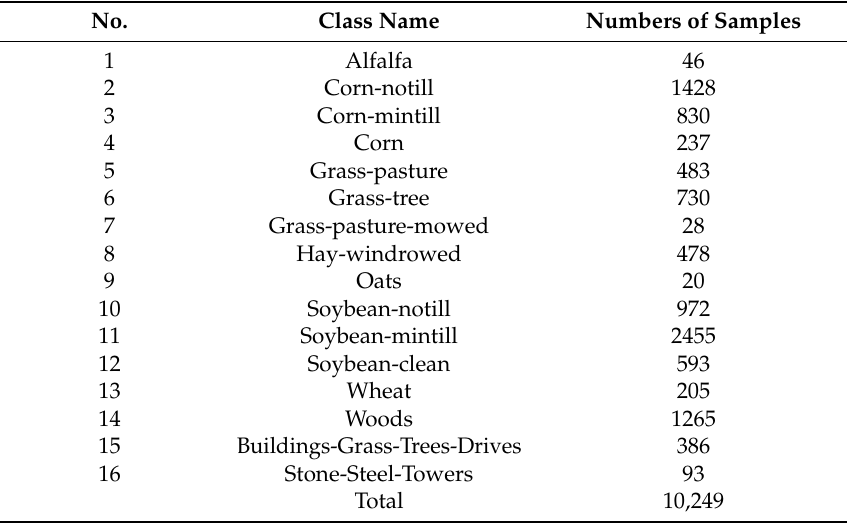
Table 1. Land cover classes and numbers of samples in the Indian Pines data set.